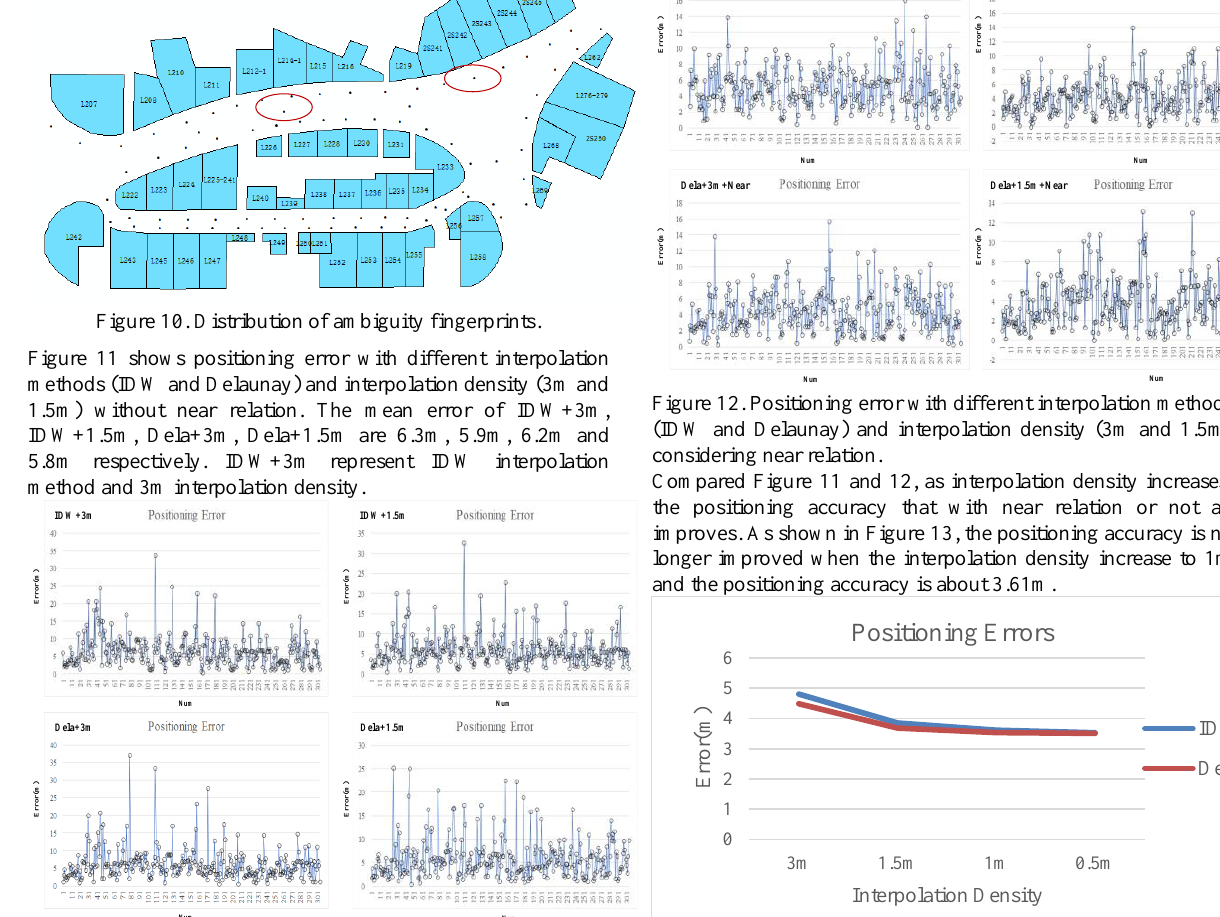
Figure 13. Positioning error of different interpolation methods (IDW and Delaunay) and interpolation density (3m and 1.5m) considering near